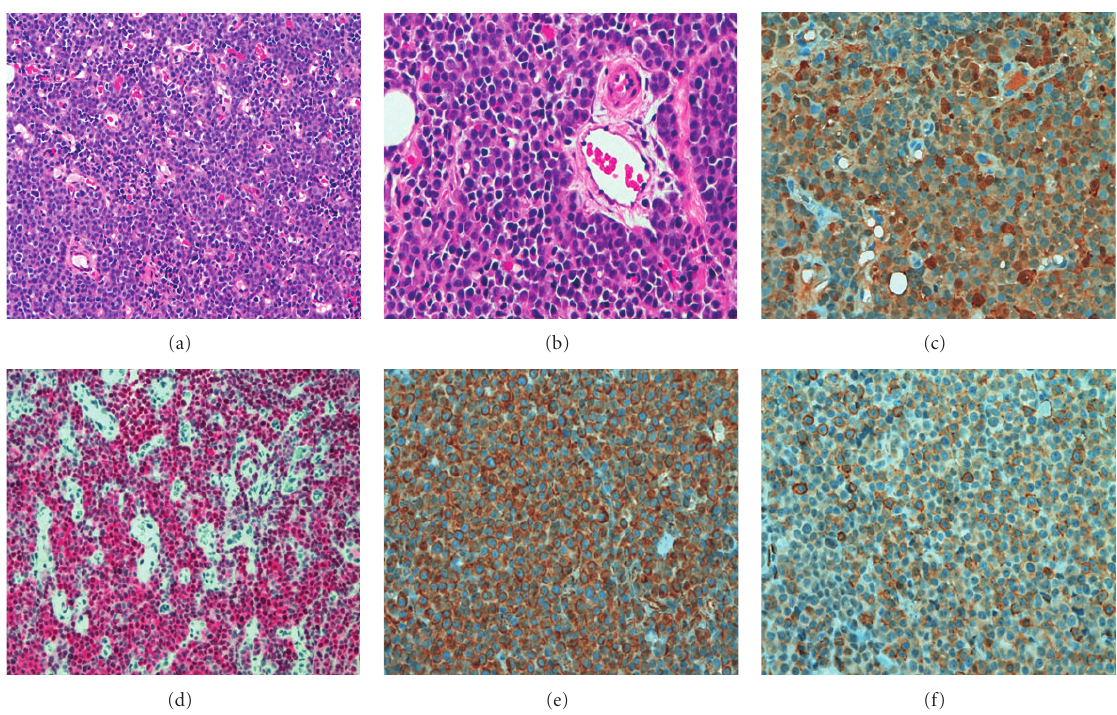
Figure 2: Histological and immunohistochemical features observed in the present case. (a-b) Histological evaluation of hematoxylin and eosin (H&E) stained sections showed a di ff used uniform proliferation of polygonal cells, showing a round to oval nucleus. Eosinophilic cell cytoplasm was variably abundant, clear to granular. (c–f) Immunohistochemically, the tumor cells were positive for S100 (c), Mitf (d), vimentin (e), and smooth muscle actin (f). (Original magnifications × 20 and ×